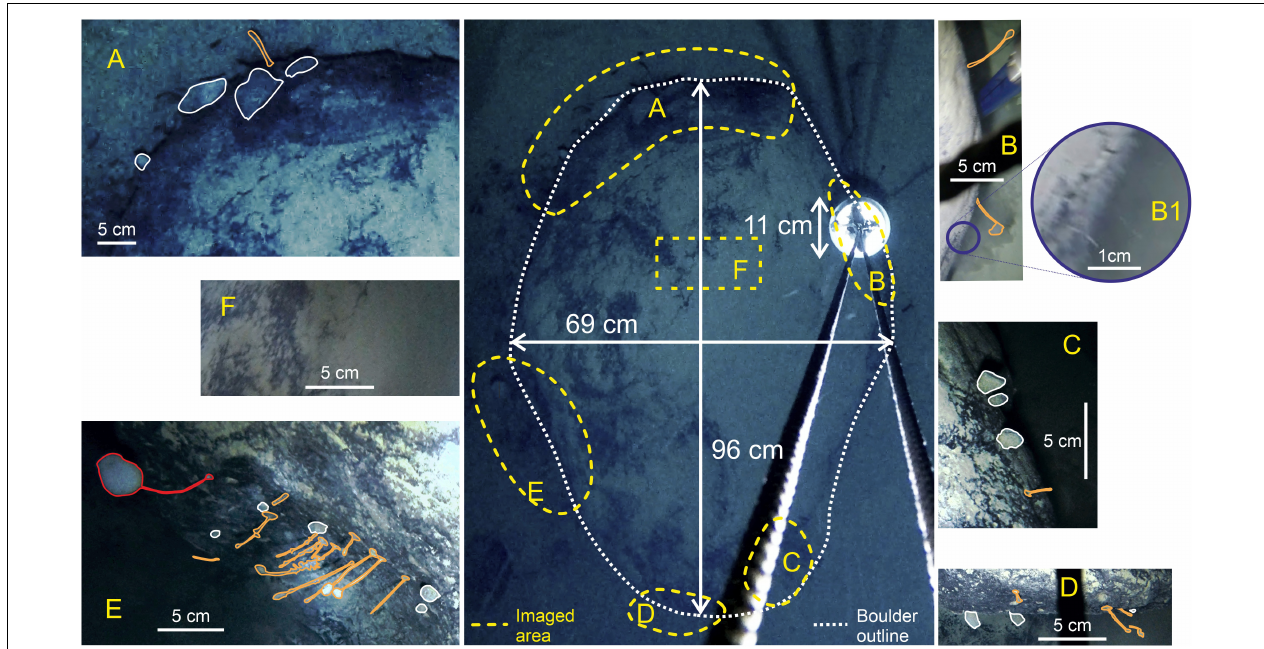
FIGURE 3 | Dimensions and close-ups of the boulder, highlighting where life is clearly visible (A–E) and the top of the boulder where no obvious life is visible (F) . The taxa visible on the boulder: Red, large stalked sponge; White, sponge; Orange, stalked taxa [possible sponge, ascidians, hydroid, barnacles, cnidaria (e.g., tubularia), and